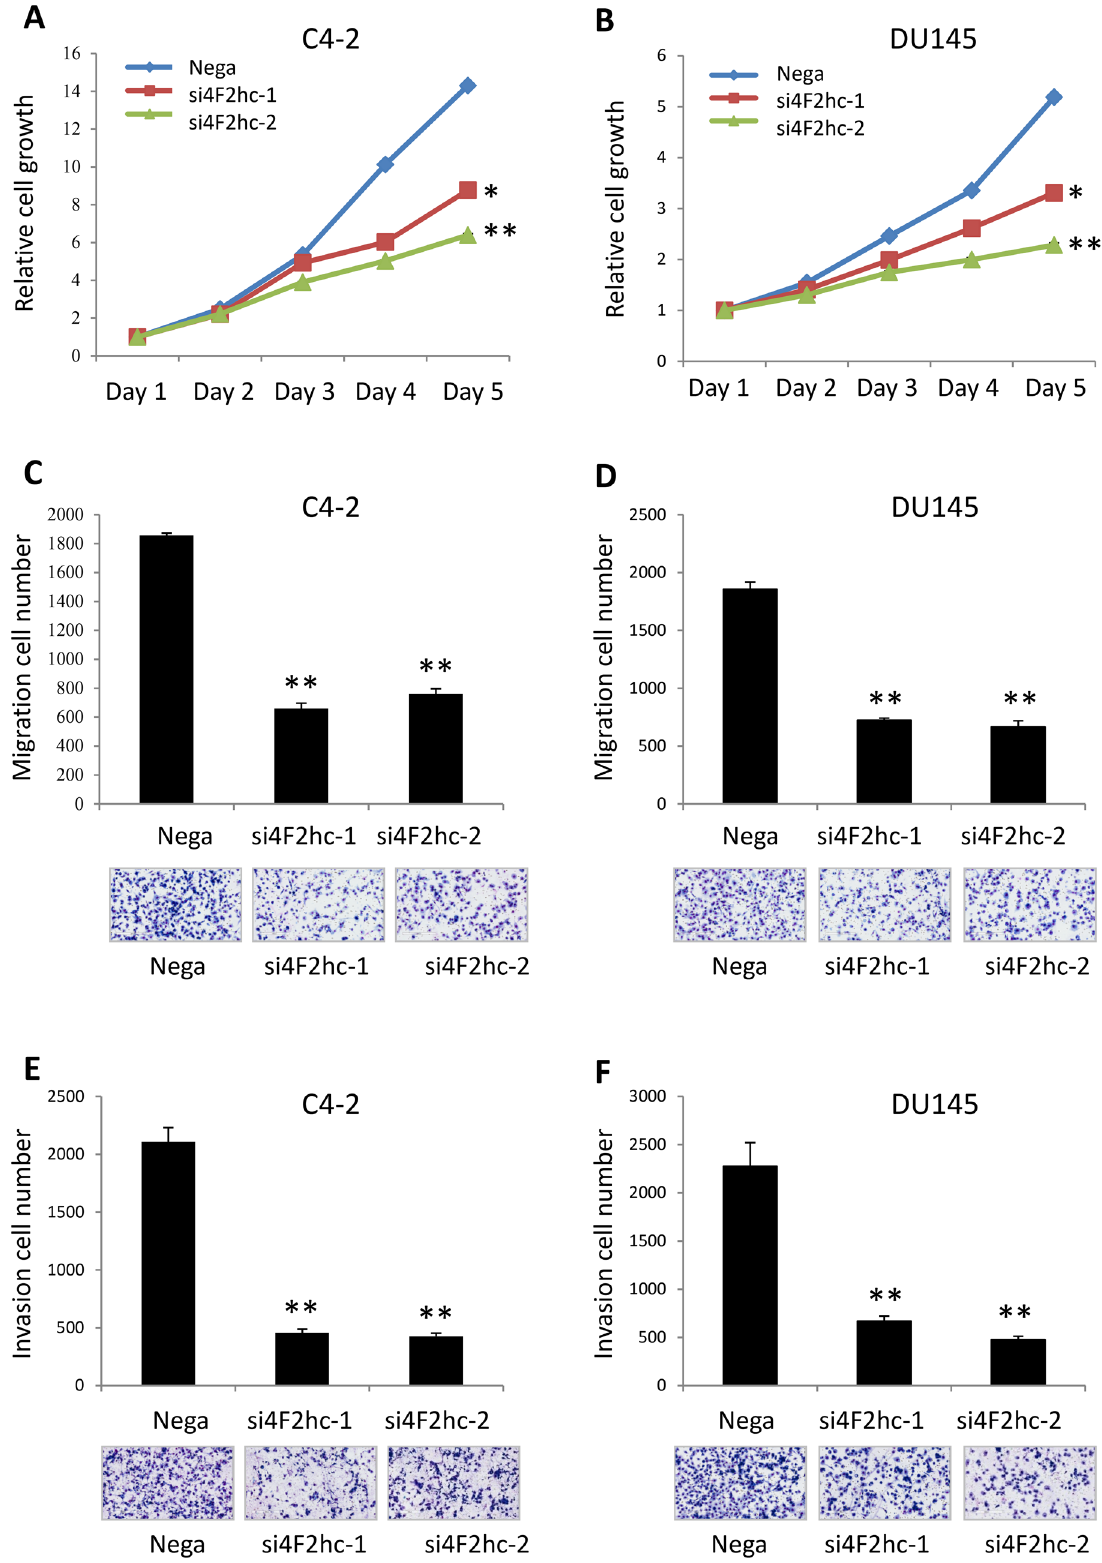
Figure 2. Functional significance of 4F2hc in DU145 and C4-2 cells. Si4F2hc (si4F2hc-1 and si4F2hc-2) inhibits C4-2 and DU145 cell proliferation ( A , B ), migration ( C , D ), and invasion ( E , F ). Nega indicates negative siRNA control. Data represent three independent experiments with similar results. P-values were calculated by the Mann–Whitney U-test. * p < 0.05, ** p <